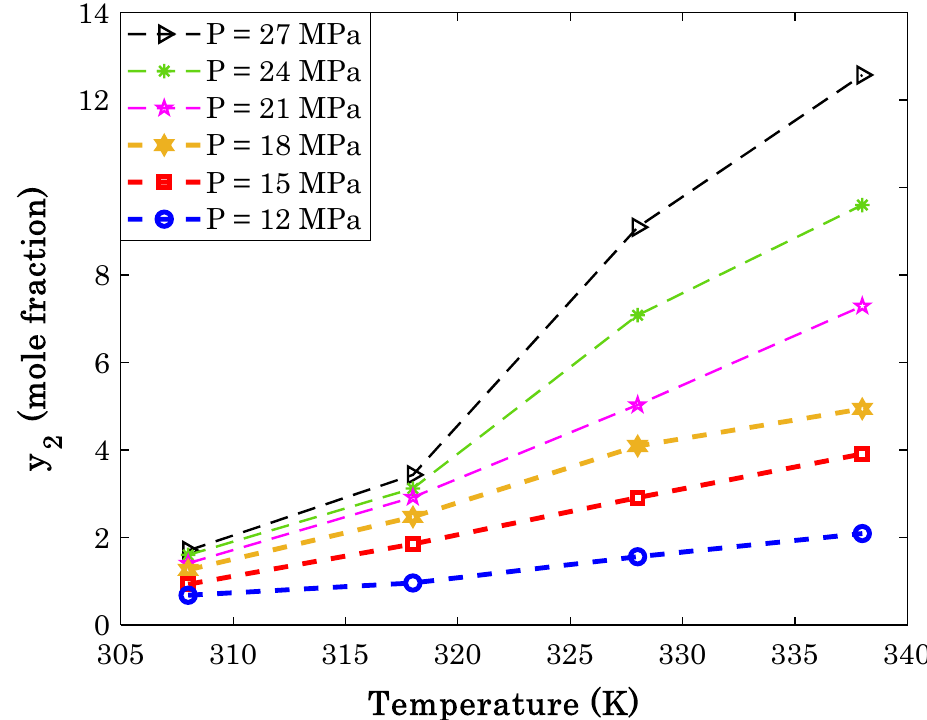
Figure 2. Dependency of sorafenib tosylate solubility in the supercritical CO 2 on the isobaric variation of temperature (the cartesian coordinate).